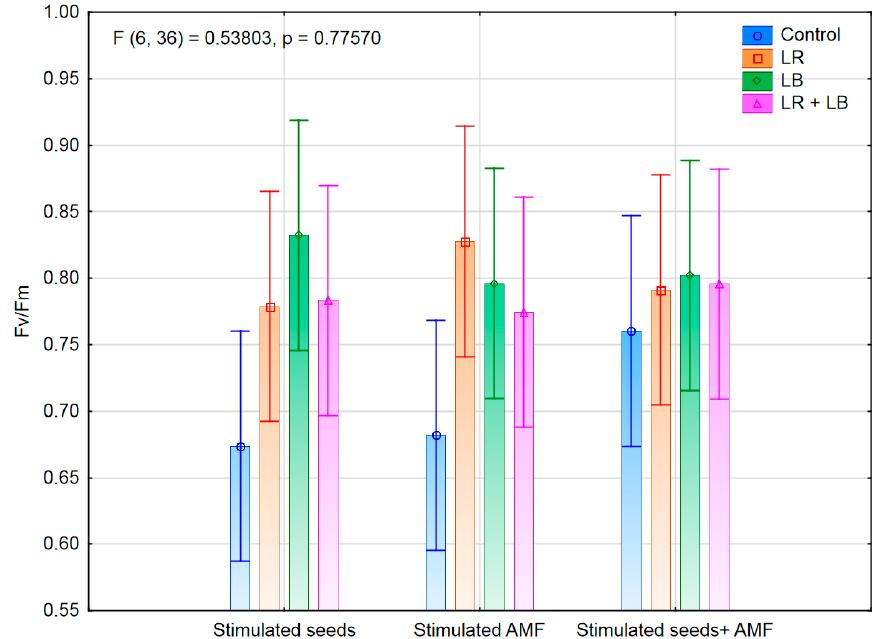
Figure 4. Effect of the interactions of the factors on the Fv/Fm parameters.